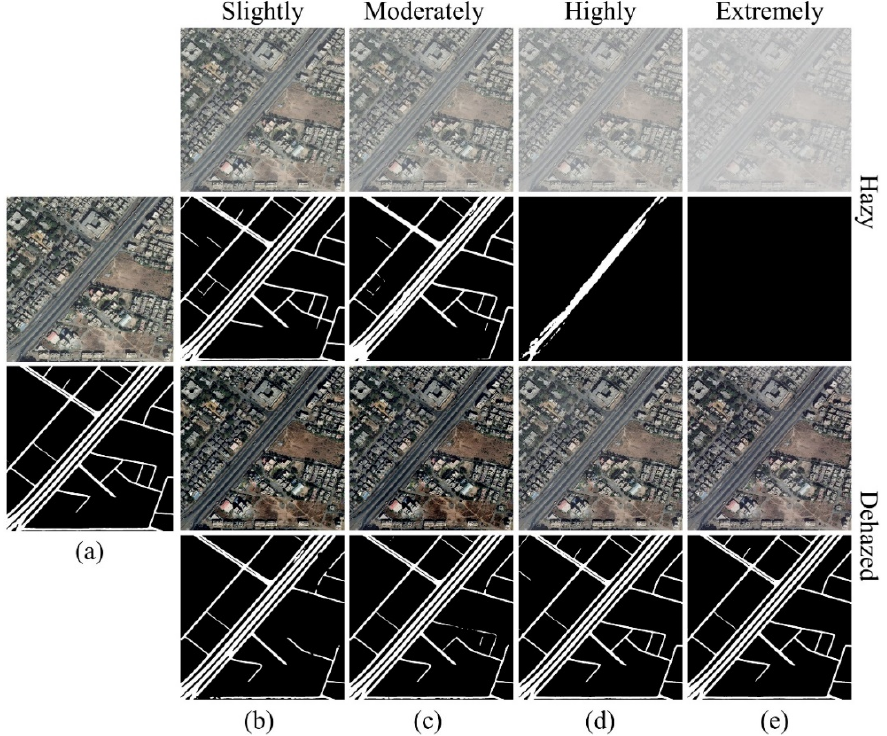
Figure 9. D-LinkNet [43] road extraction results using the dehazed images by the proposed dehazing method, where ( a ) is the reference clear image and the corresponding road extraction result. The first and second rows of ( b – e ) are the hazy images of different densities and the corresponding road extraction results. The third and fourth rows of ( b – e ) are the dehazed images by our proposed method and the corresponding road extraction results.